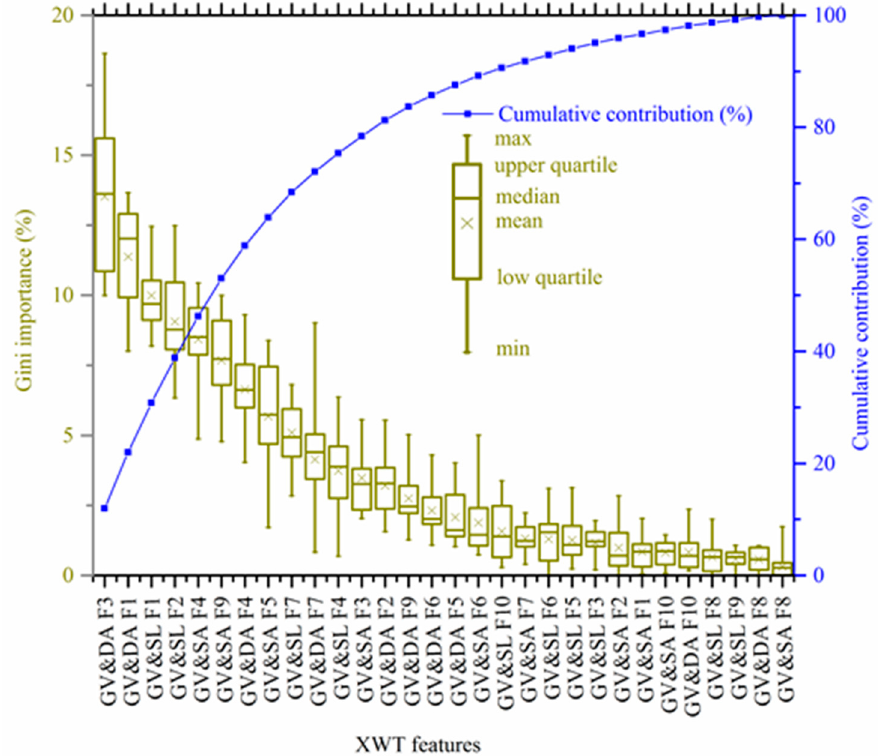
Figure 3. Gini importance and cumulative contribution of the XWT features. The dark yellow boxplot is the Gini importance (%) of 20-fold repetitions of the RF model. The blue line is the cumulative contribution of the sorted XWT features. The XWT features are represented as the coupling of specific vegetation and soil-related endmember pairs (GV and DA, GV and SL, GV and SA) and relative XWT features (from F1 to F10).